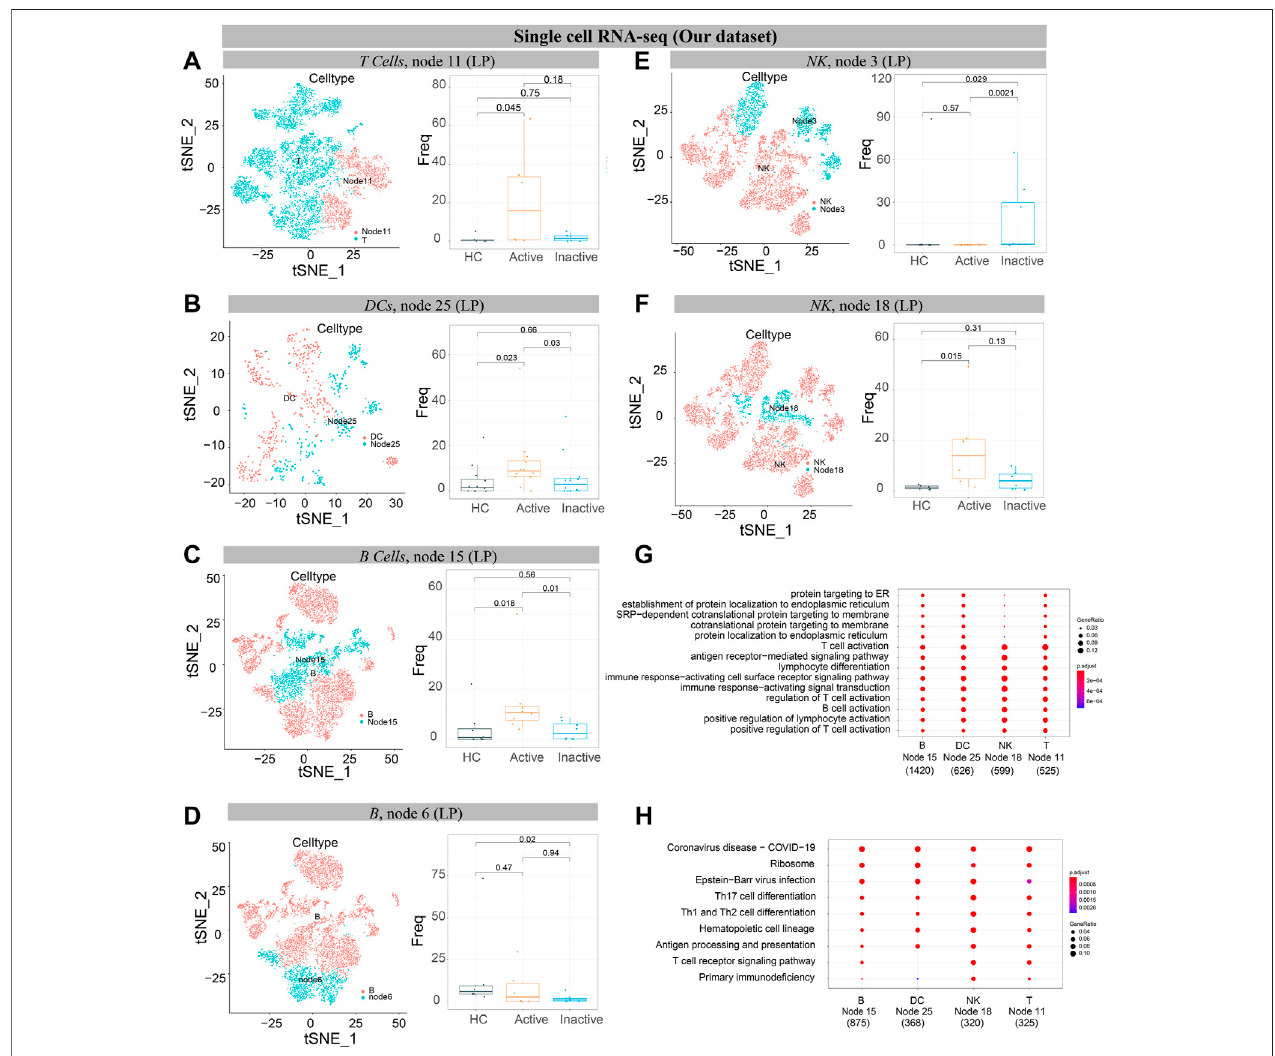
FIGURE 9 | Veri fi cation of single cells derived from UC and healthy samples. (A – F) t-SNE plots of T cells (A) , DCs (B) , B cells (C, D) , and NK cells (E, F) from 6 participants ’ mucosa (LP) samples (our dataset). “ Node ” labels in t-SNE plots indicate the same subclusters as nodes in CyTOF (left). Boxplot of selected T cell (A) , DC (B) , B cell (C,D) , and NK cell (E,F) cluster abundances in mucosa (LP) samples of HC, UCa and UCin (right), with Wilcoxon rank-sum test results; statistical signi fi cance was set at p < 0.05. (G) The GO enrichment analysis. (H) The top 10 signaling pathways according to KEGG